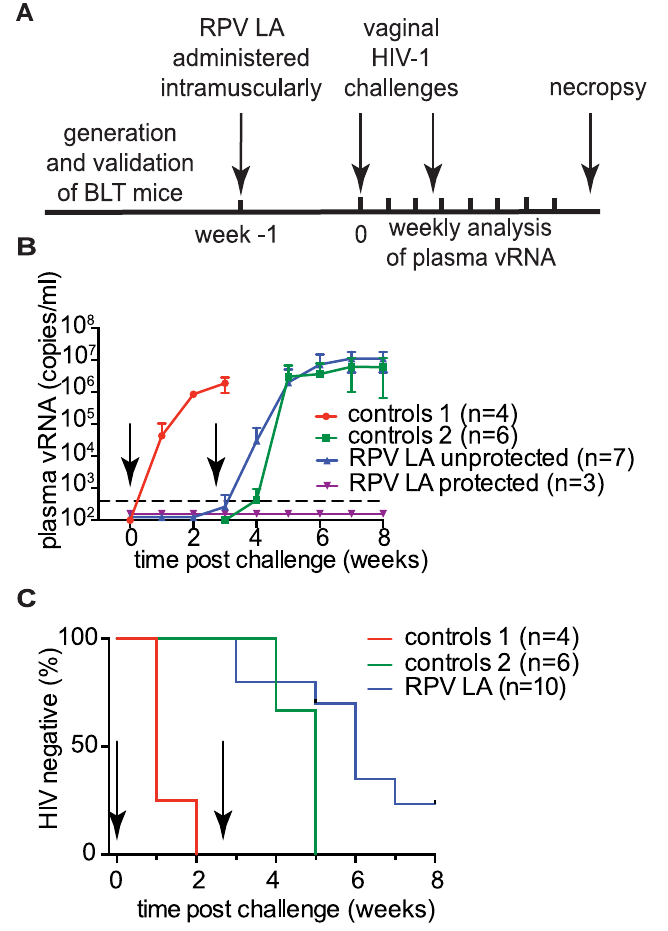
Fig 5. Analysis of RPV LA protection after exposure to high doses of multiple transmitted/founder viruses and an early passage primary isolate. (A) Experimental design. BLT mice were challenged with CH040, RHPA or JR-CSF HIV-1 isolates 1 week after RPV LA administration. Four weeks after RPV LA administration, mice were challenged again, but this time with HIV-1 THRO , a transmitted/founder virus. (B) Plasma viral load in RPV LA treated BLT mice (n = 10) and controls (n = 4 for 1 st challenge, n = 6 for 2 nd challenge). Dash line indicates LOQ. Data are presented as mean ± SD. (C) Kaplan-Meier plots representing the percentage of BLT mice protected against HIV transmission by RPV LA intramuscular injection as a function of the number of weeks post 1 st and 2 nd challenges until the first peripheral blood viral RNA detection. Arrows in panels (B) and (C) indicate time of 1 st and 2 nd challenges. RHPA (n = 2) and CH040 (n = 2) were used as controls for the first challenge (Control 1); for the 2 nd challenge, all control animals were exposed to THRO (n = 6; Control 2); RPV LA indicates RPV LA treatment. Statistical analysis: Log-rank (Mantel-Cox) test, 1 st and 2 nd challenge were analyzed separately, controls 1 vs. 1 st challenge p = < 0.0001, controls 2 vs. 2 nd challenge p =